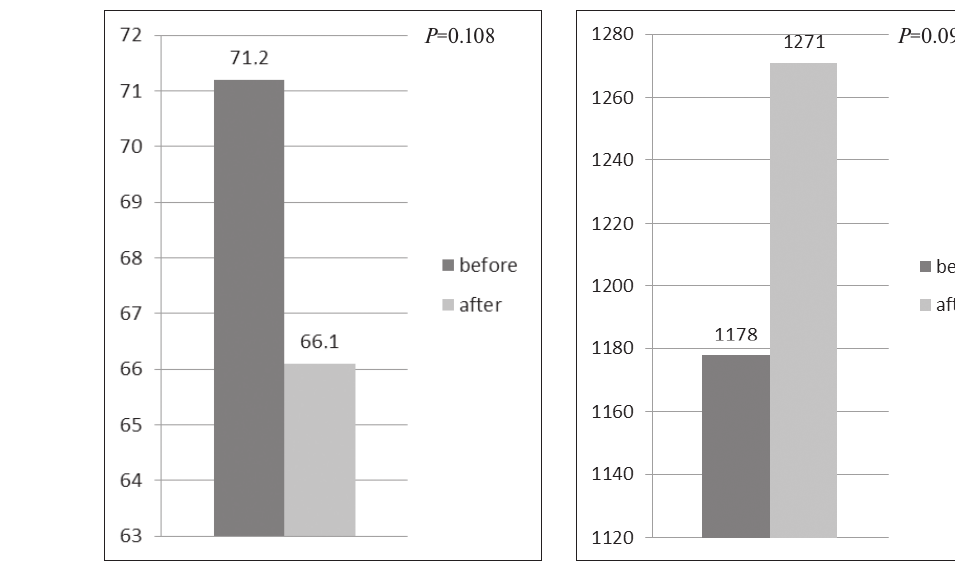
Fig. 1C. Changes in albuminuria (mg/L). Fig. 1D. Changes in C-peptide